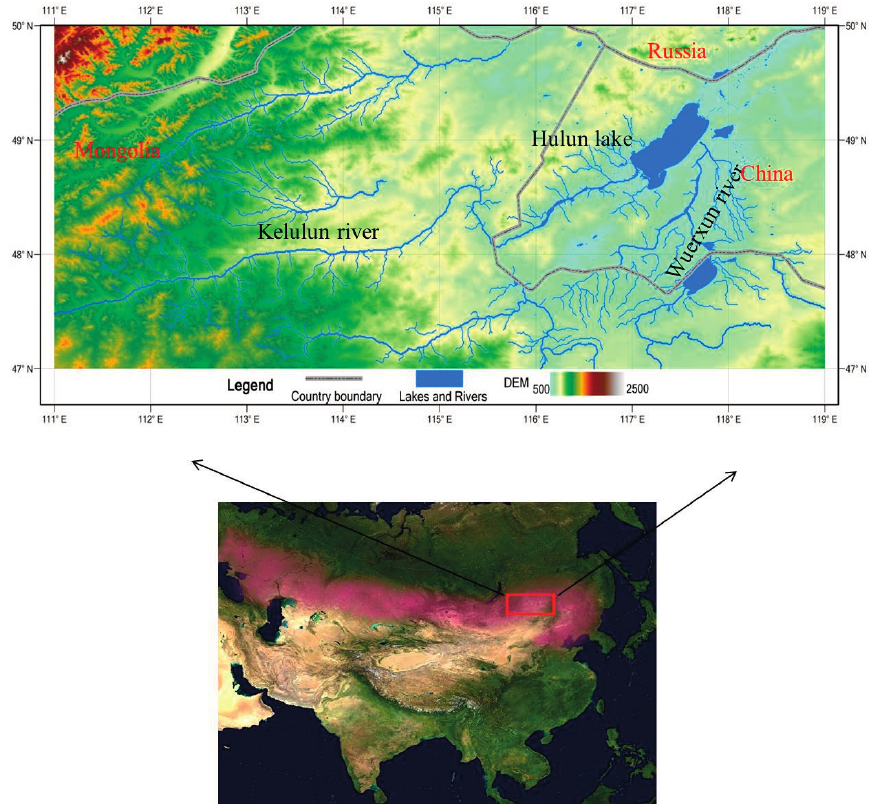
Figure 1. The geographic location and Shuttle Radar Topography Mission (SRTM)-based elevation map of the study area (red color region in the down figure shows the Eurasian Steppe